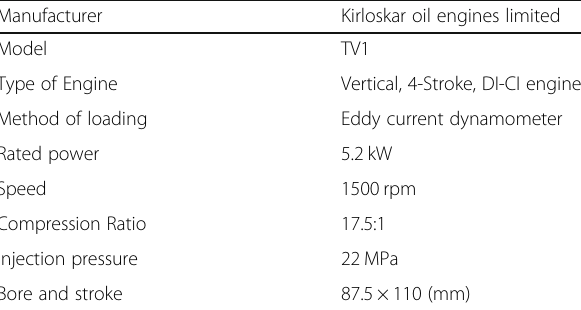
Table 3 Specifications of the engine